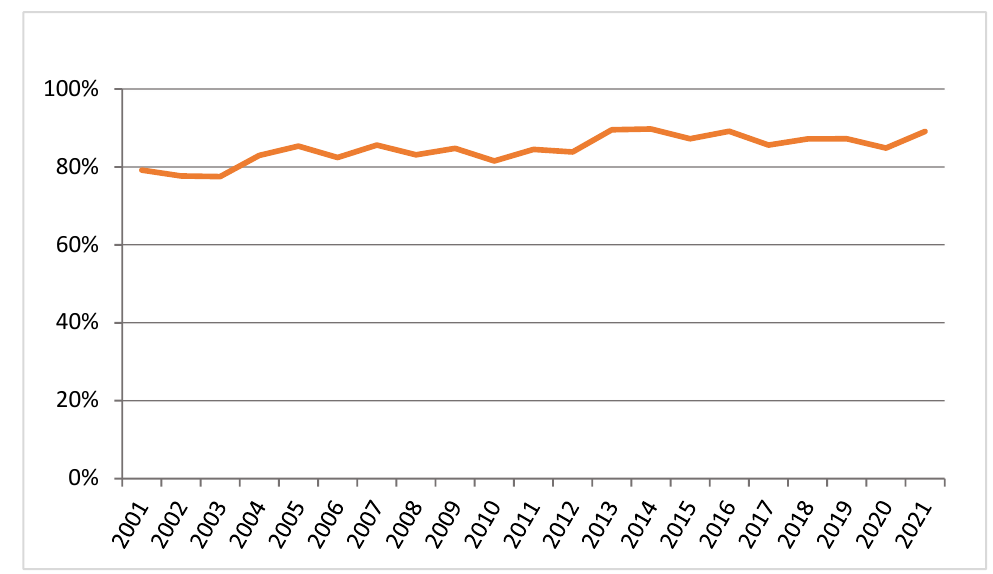
Figure 9. Trends of intact AAA repair performed by tertiary vascular centres.